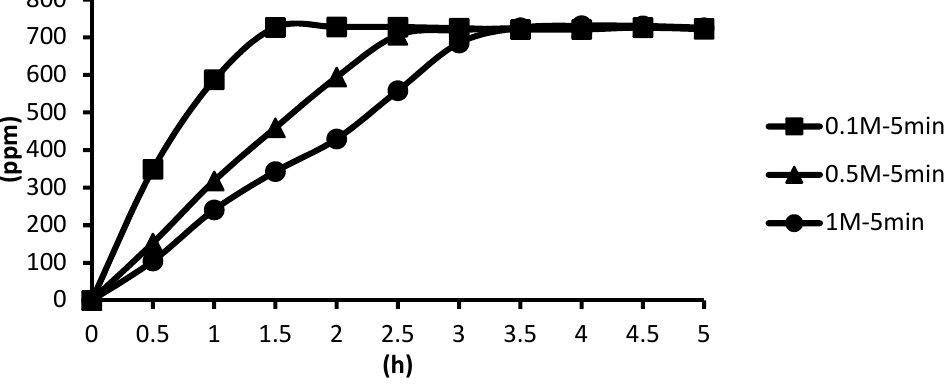
Figure 22. The effect of ZnCl 3 concentration (cross-linking time of five minutes) on releasing of tea tree essential oil from alginate/tea tree essential oil microcapsules in the hot spring water.